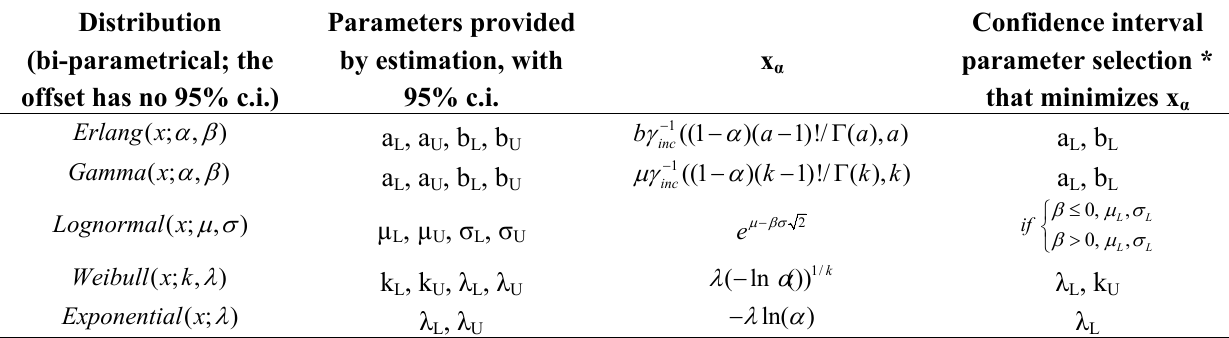
Table 6. Confidence interval parameter selection that minimizes x parametrical distribution